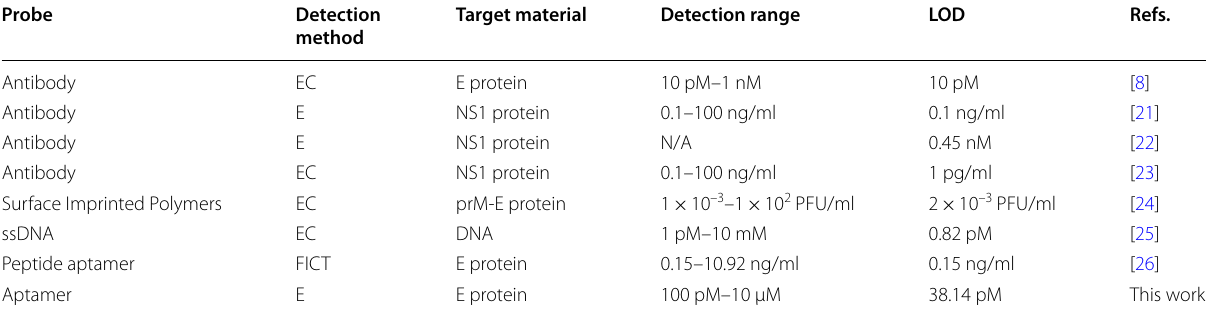
Table 2 Biosensor comparison table for Zika virus detection Probe Detection method